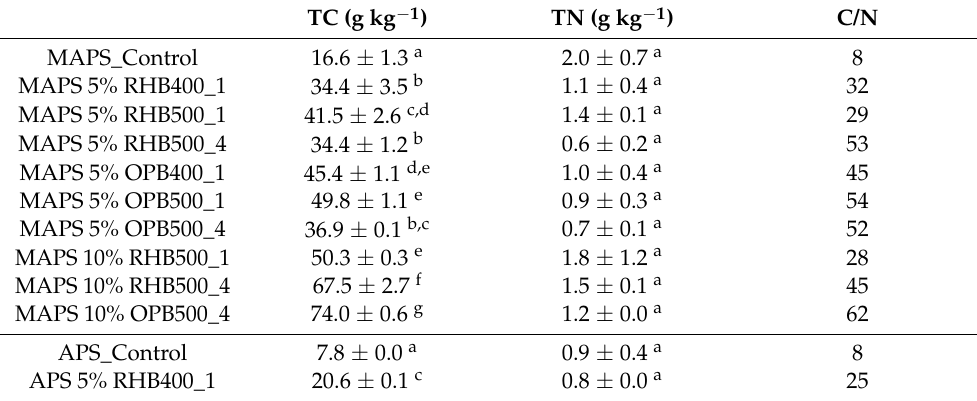
Table 2. Elemental analysis of control and biochar-amended soils after 65 days of